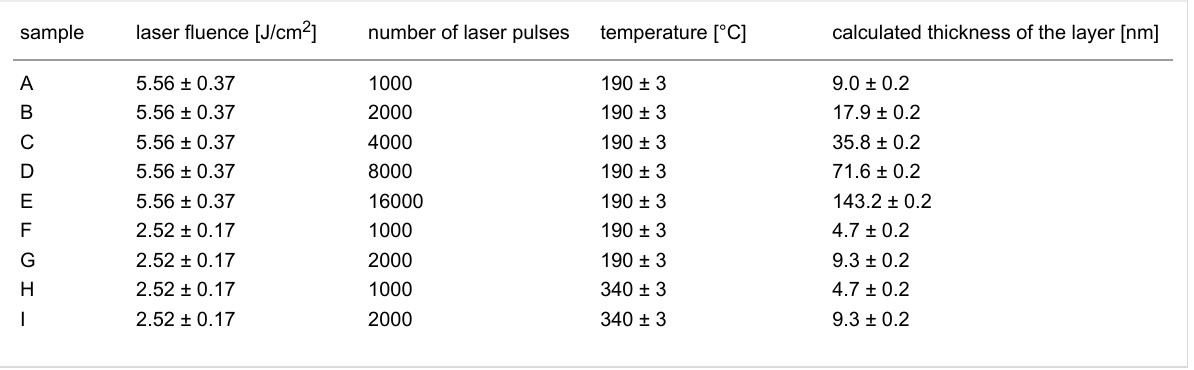
Table 1: The parameters used during the deposition of the SNIFs by PLD (repetition rate 5 Hz; pressure 4.6 × 10 − 5 mbar).